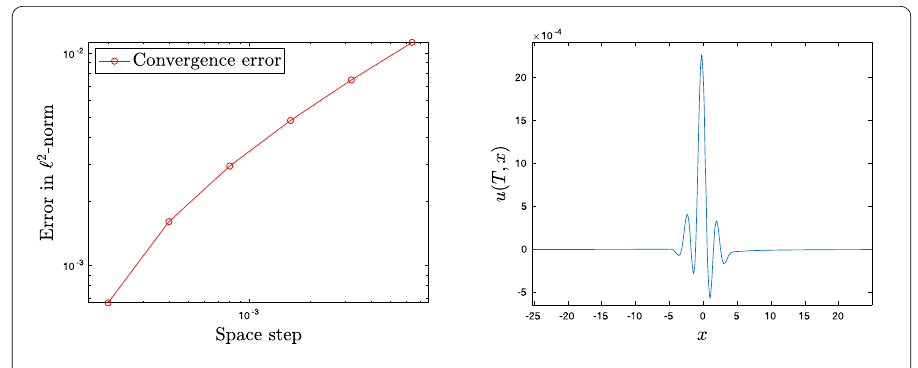
Figure 5 Numerical experiment 3. (Left) Graph of convergence (cid:14) u NT (cid:2) logscale. (Right) Solution to (24) at t = T